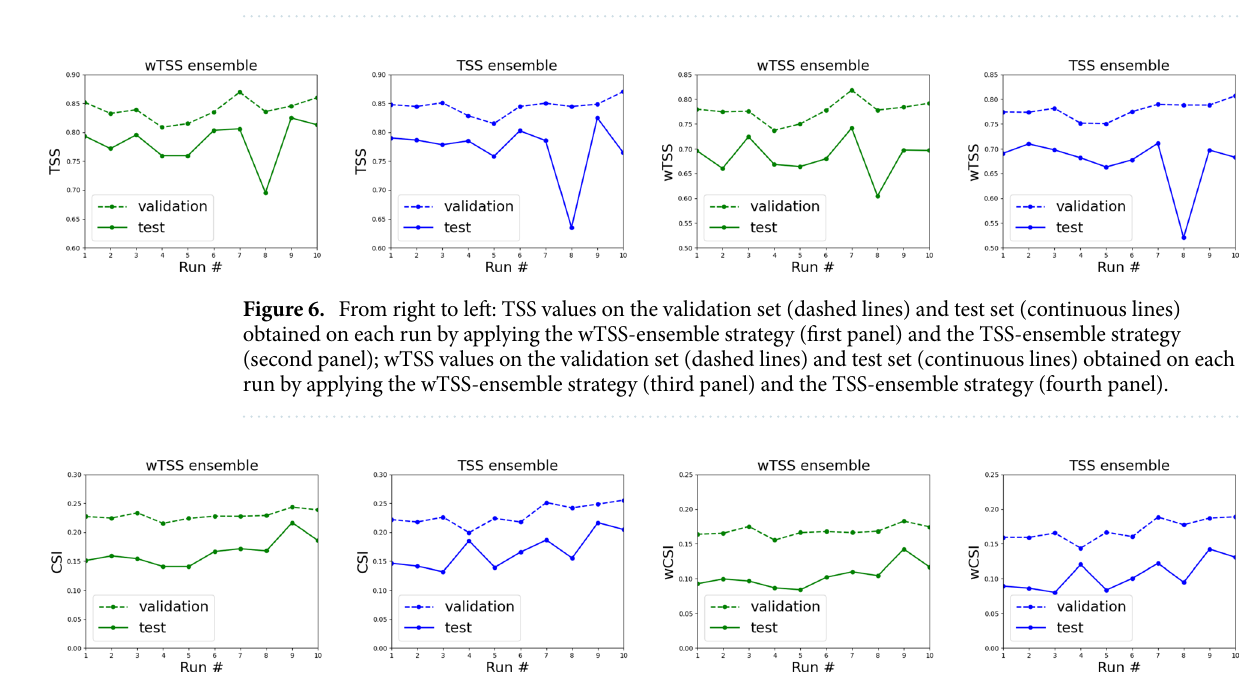
Figure 5. Learning curves showing the behaviour of the training (left panel) and validation (right panel) loss along epochs for the ten runs.